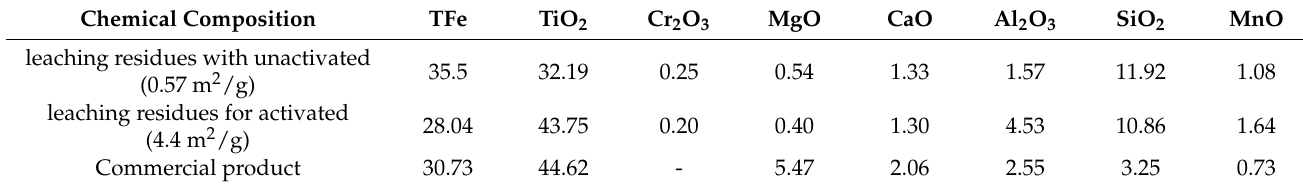
Figure 10. SEM image ( a ), EDS patterns ( b ) and area elements content ( c ) of the leaching residues sample. Table 2. Chemical composition of the leaching residues (wt. %).